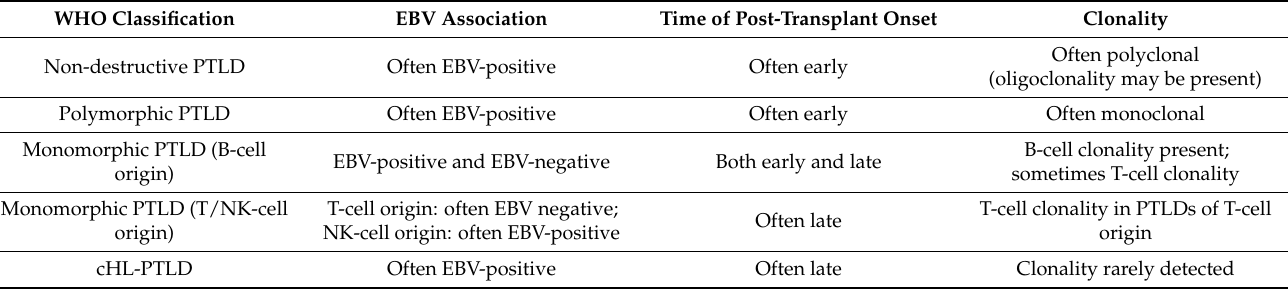
Table 2. Characteristics of